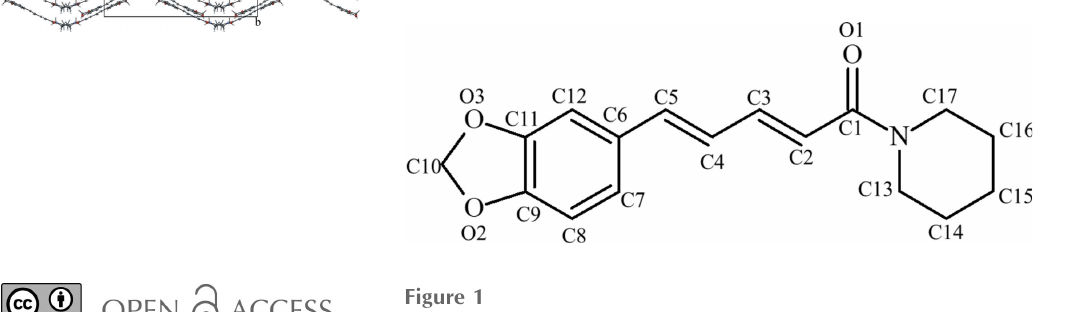
Figure 1 The chemical structure of